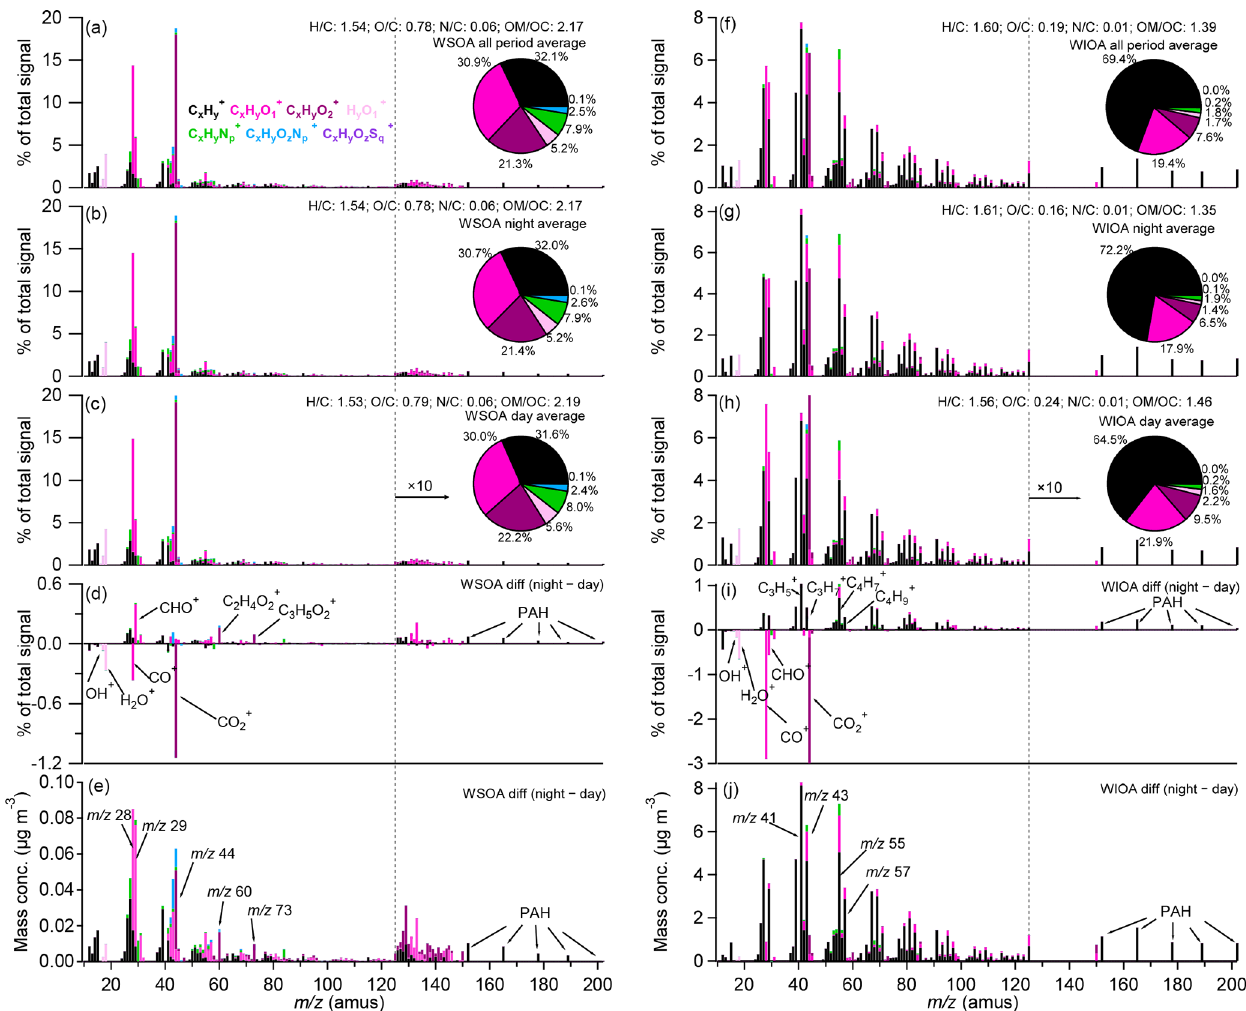
Figure 5. Mass spectra of (a,f) all-period, (b,g) night, (c,h) day, and (d,i) night-day differences of signal fraction and (e,j) night-day differences of mass concentration of WSOA and WIOA, respectively, also shown in (a–c) and (f–h) are the ions fraction pie charts of WSOA and WIOA, respectively, note that the value of the mass spectra with m/z s larger than 125 are multiplied by 10 for more intuitive display.